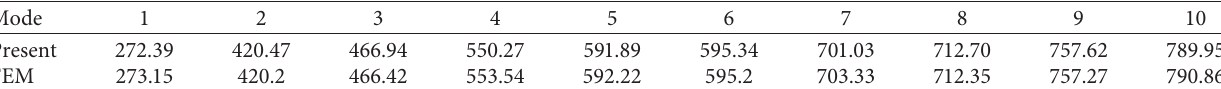
Table 5: Numerical comparison of frequencies for Sandwich FGP elliptical shell accompanied with F-C boundary condition.